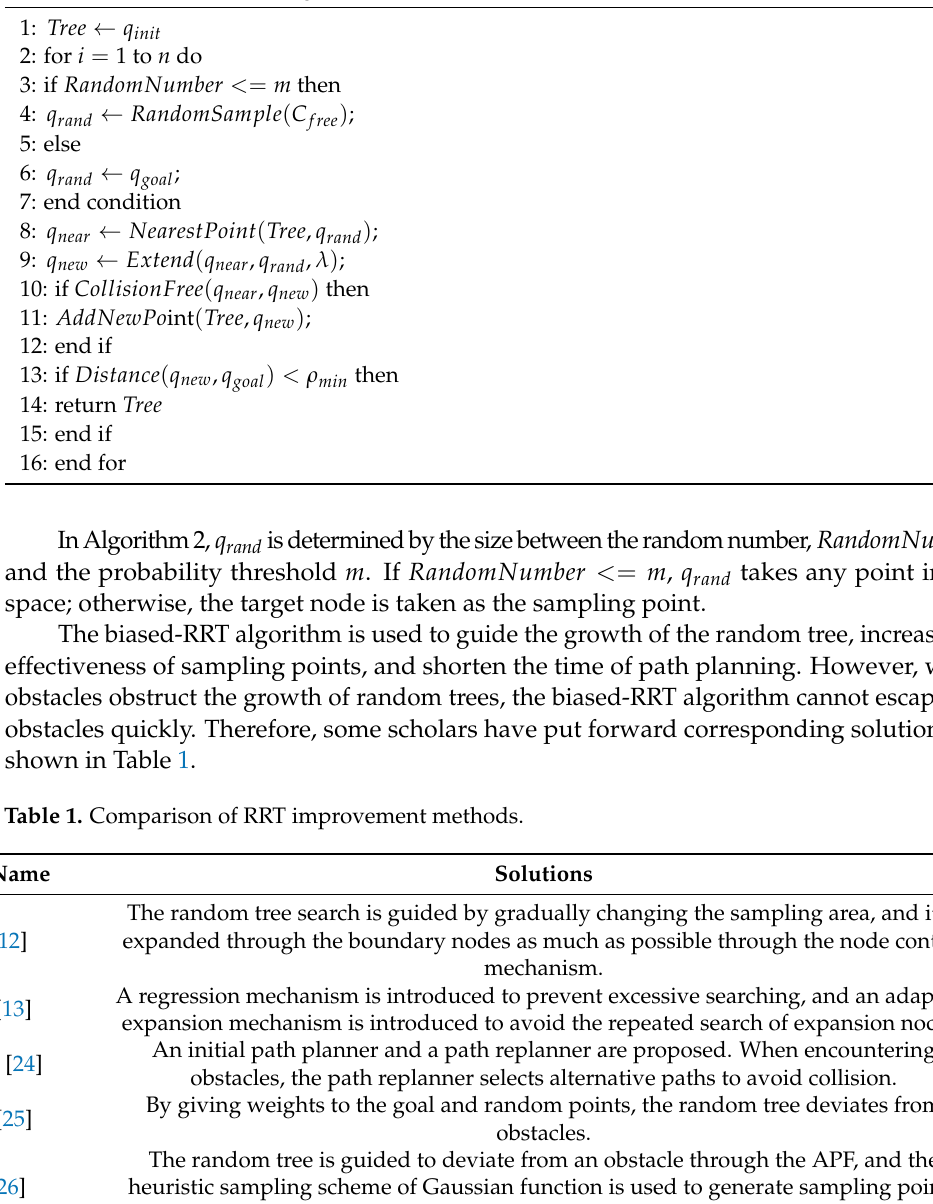
Algorithm 2. Biased-RRT Algorithm.